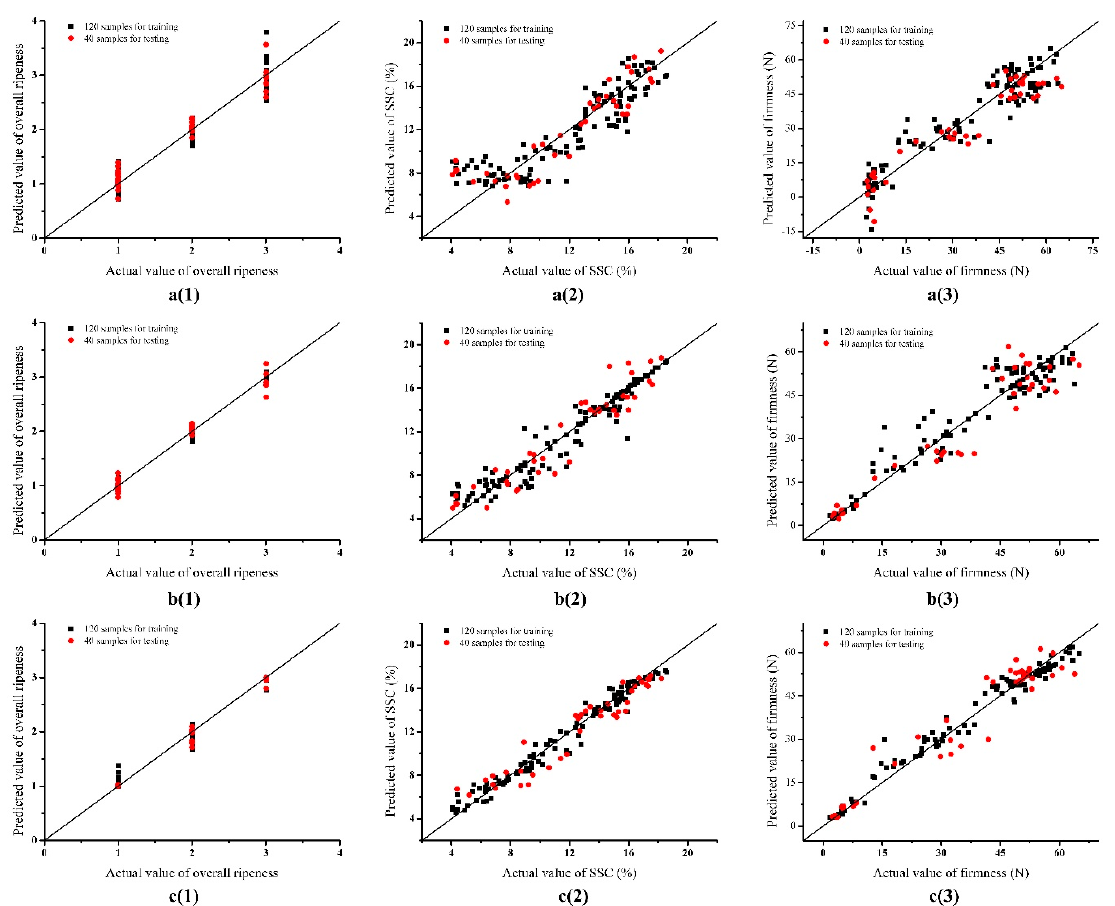
Figure 4. Predicted versus actual values from different prediction models: ( a ) presents PLSR, ( b ) presents SVM, and ( c ) presents RF; (1) stands for overall ripeness, (2) stands for SSC, and (3) stands for firmness.